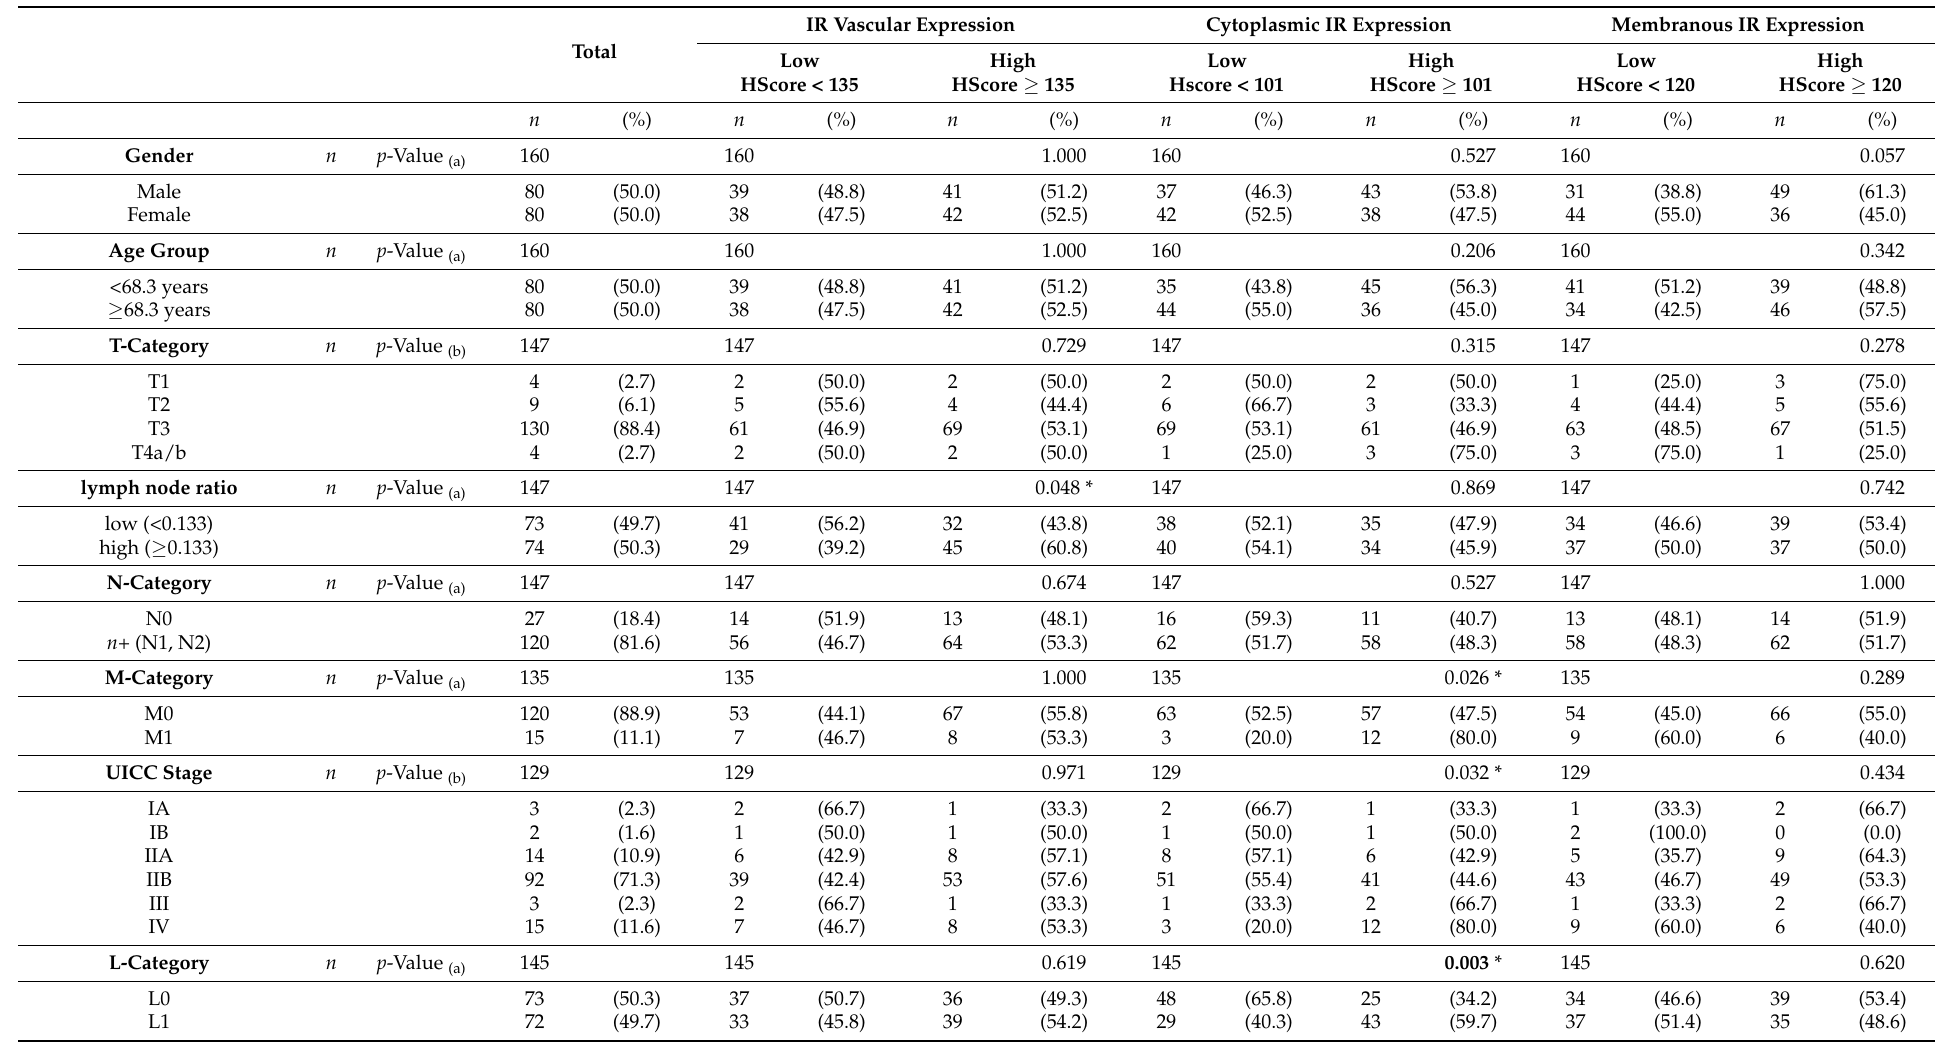
Table 1. Correlation between clinicopathological patient characteristics and the expression of the insulin receptor (IR) in cancer vessels and cells in PDAC tissues. IR Vascular Total